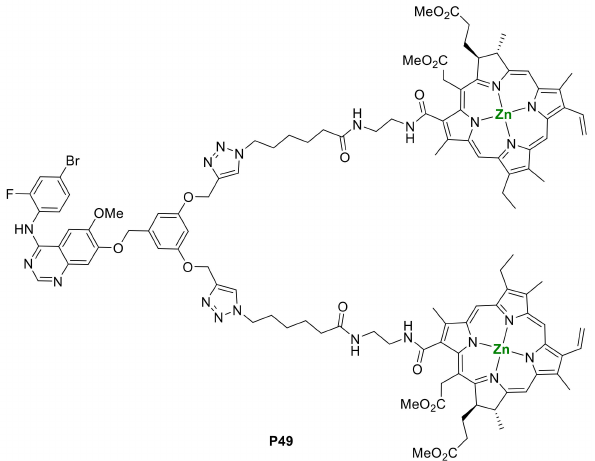
Figure 4. Structure of bis(chlorin)-quinazoline derivative P49